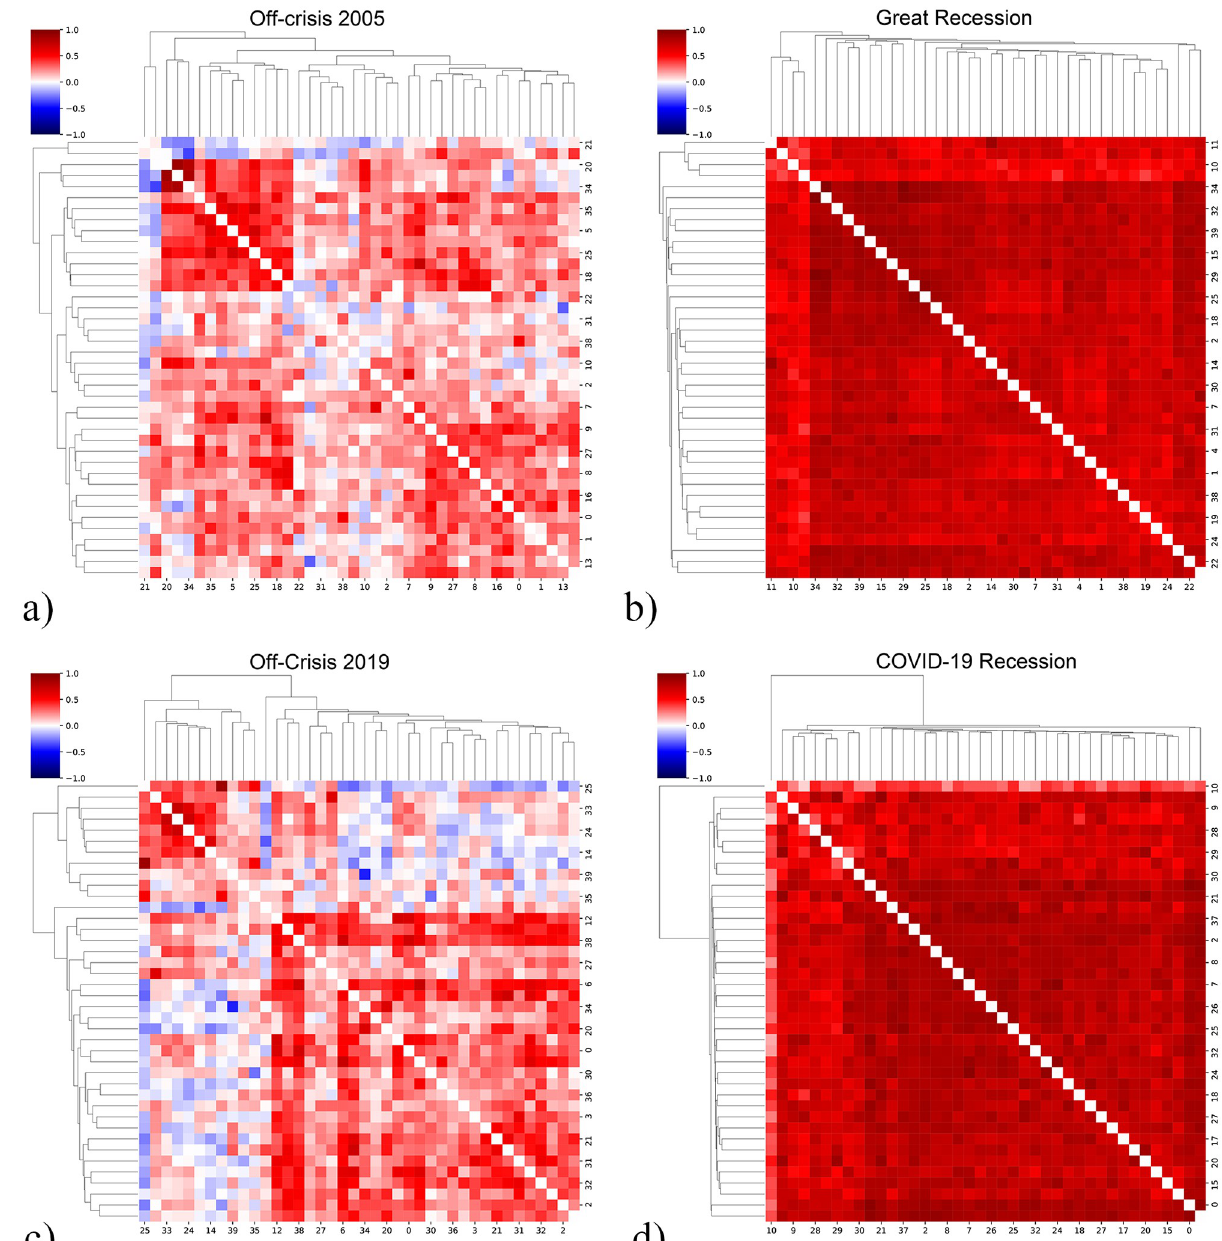
Fig 3. The correlation matrix of stocks in on and off crisis periods. Heatmap of the correlation matrix in a,c) Off-crisis and b,d) On-crisis periods. We use dendrogram to detect communities inside the correlation matrices and to illustrate the similarity of elements. There is no noticeable correlation between stocks in off-crisis (a,c) while in on-crisis (b,d) we see a strong correlation of the